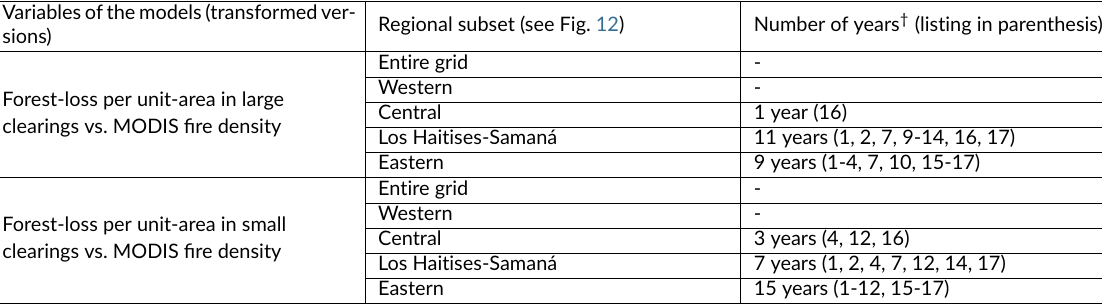
Table 3 – Number of years in which the coefficients of the annual spatial error models were not significant, considering the entire grid and different regional subsets.